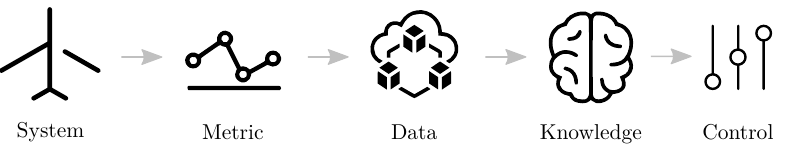
Figure 1. Step-by-step virtualization of ATM (sub-)systems to enable data-driven